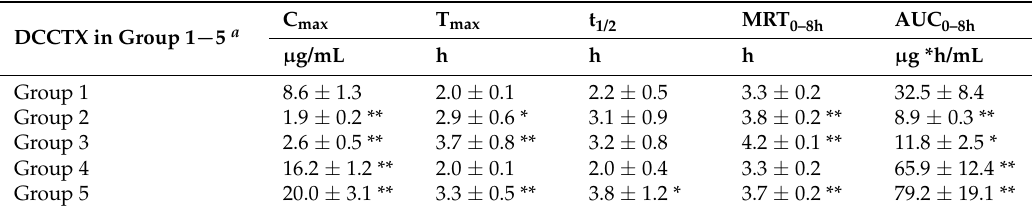
Table 1. Pharmacokinetic parameters of DCCTX after CTX (300 mg/kg, i.v.) administration, with different time intervals after Gom A administration, in groups 1 − 5 a .